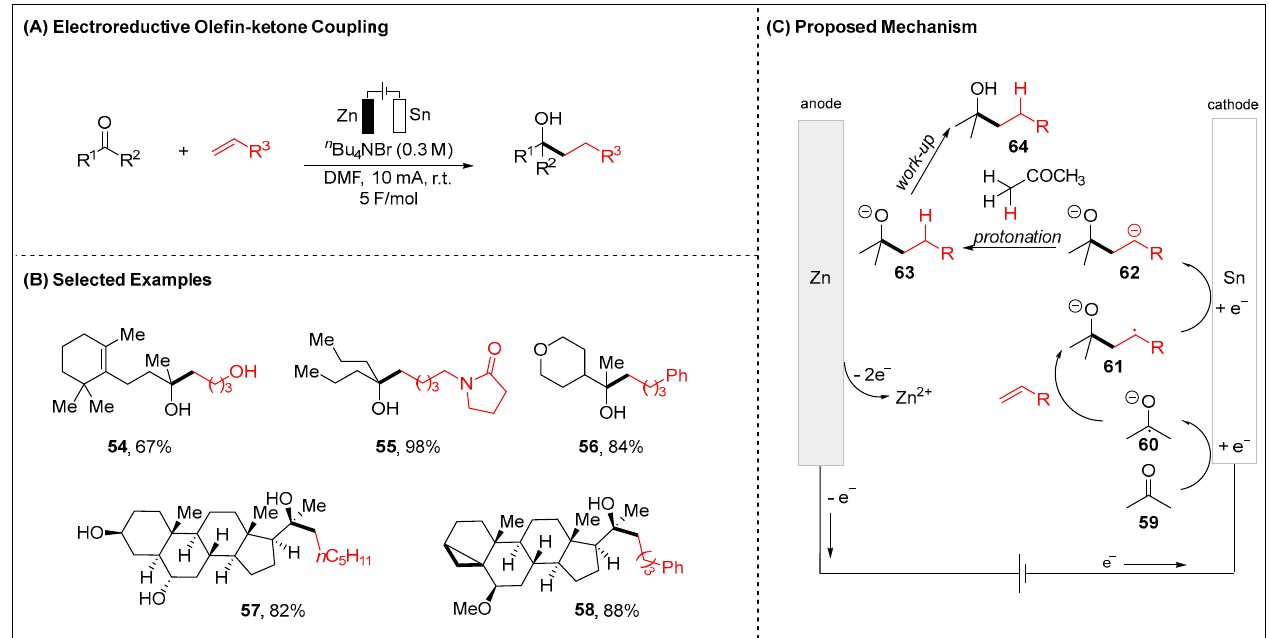
Figure 8. Electroreductive ole fi n − ketone coupling for the mild synthesis of tertiary alcohols.